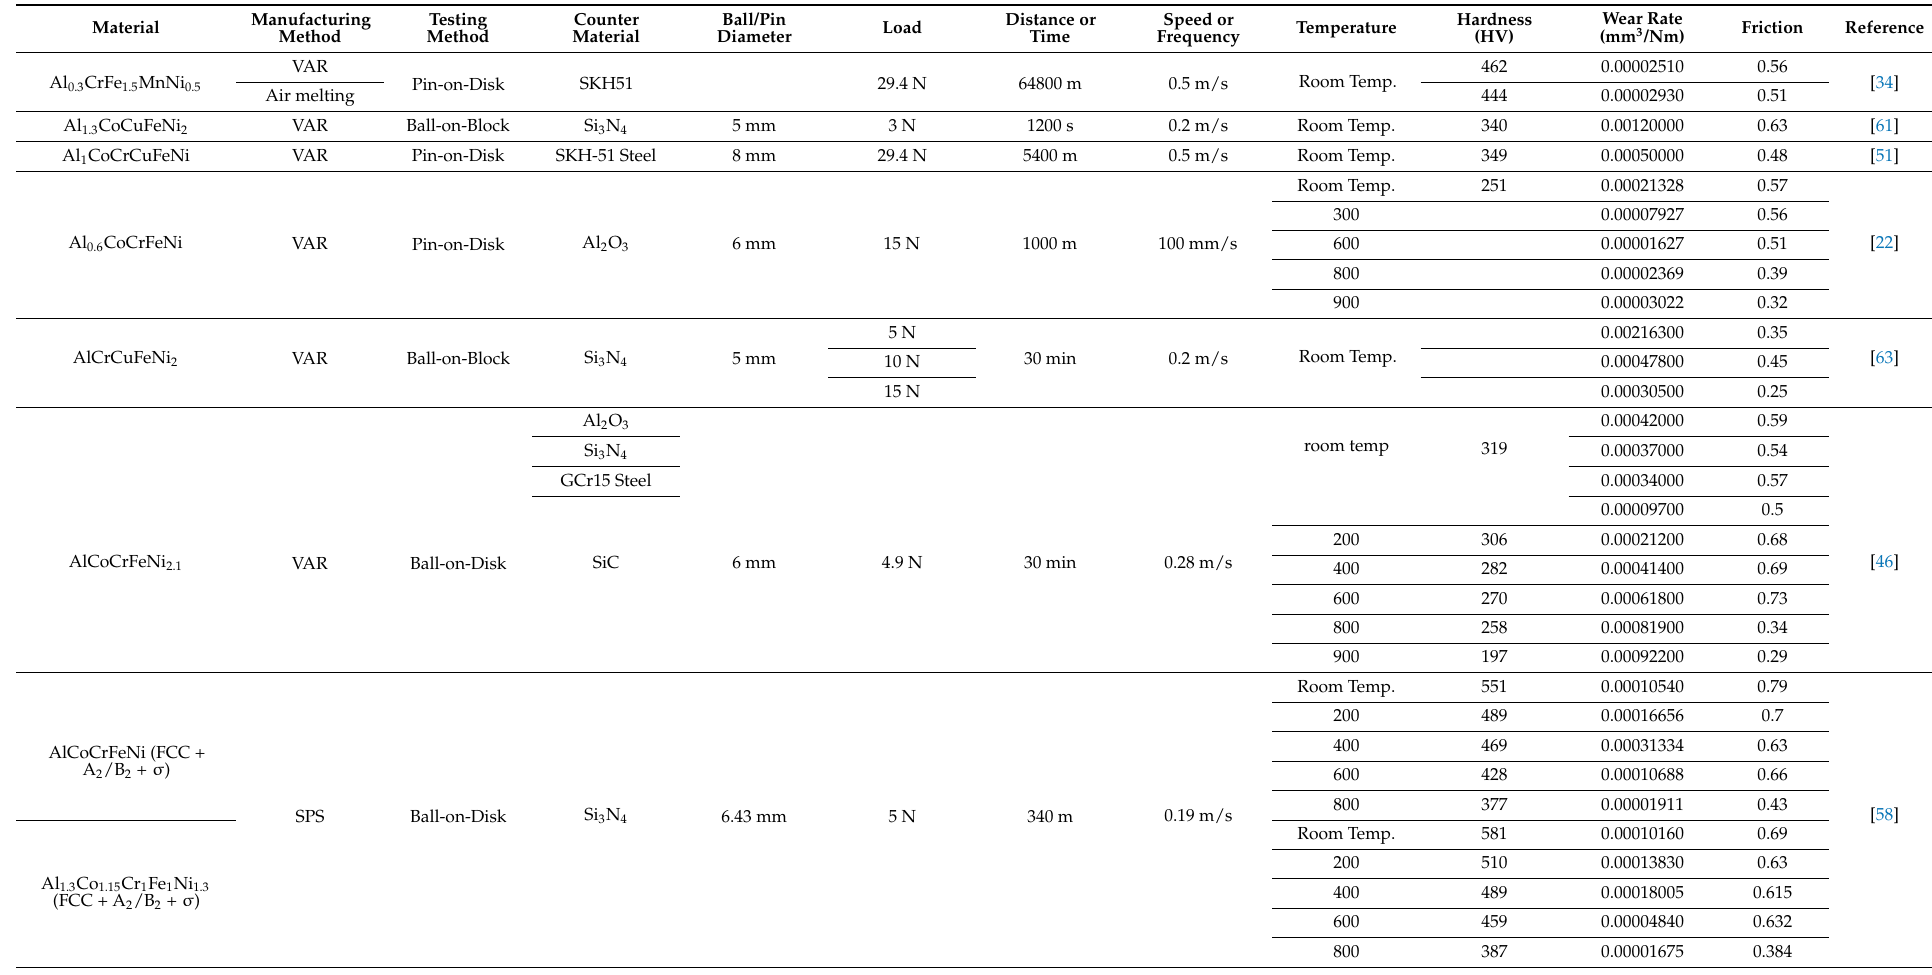
Table 3. FCC + BCC phase group test procedures and tribological